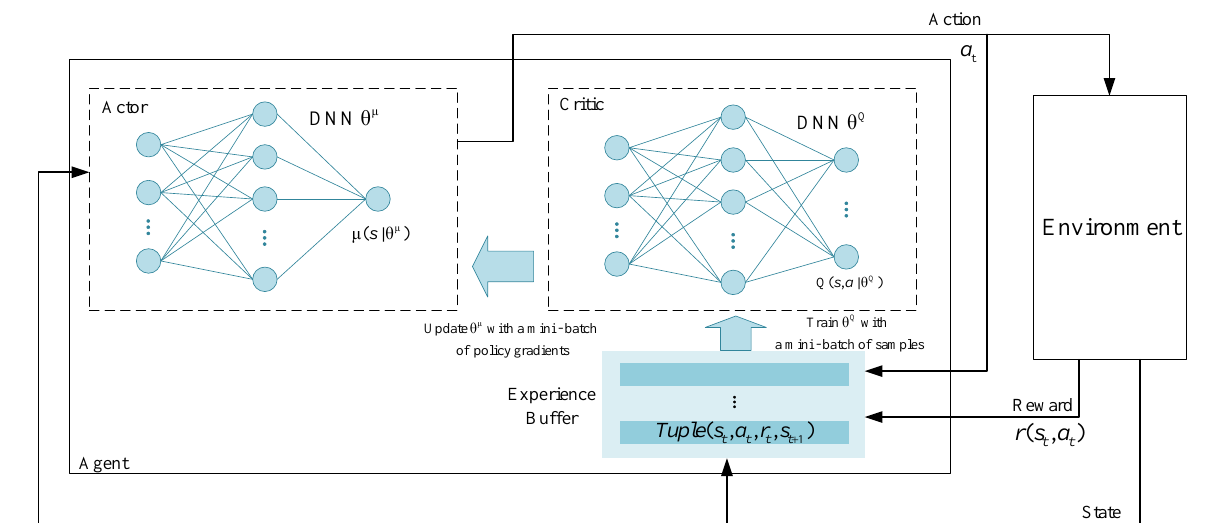
Figure 5. The DDPG algorithm: a model-free, off-policy, and actor–critic